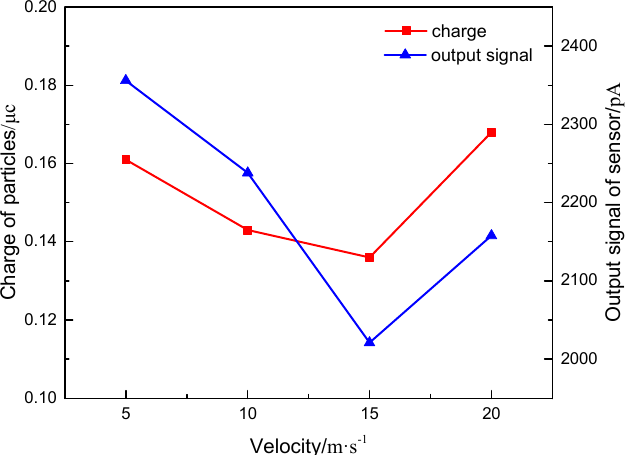
Figure 13. The relationship of charge of particles and output signal of sensor changing with different exhaust velocity.